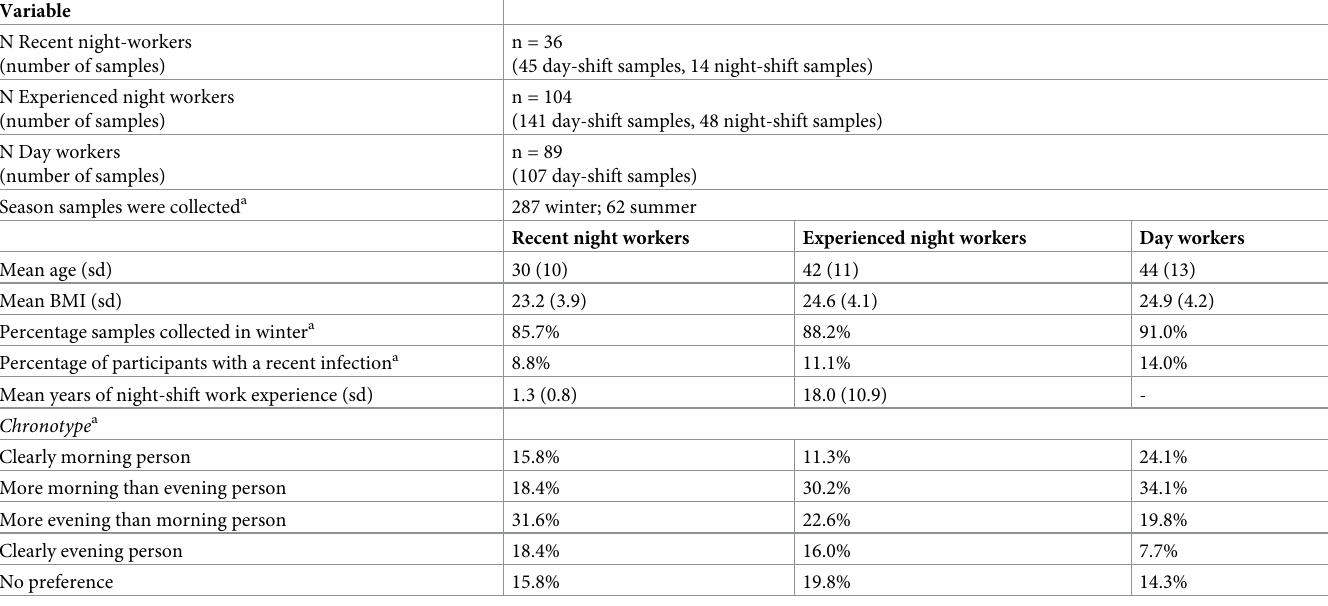
Table 1. Description of the study population (total number of individuals = 230, total number of observations = 355).